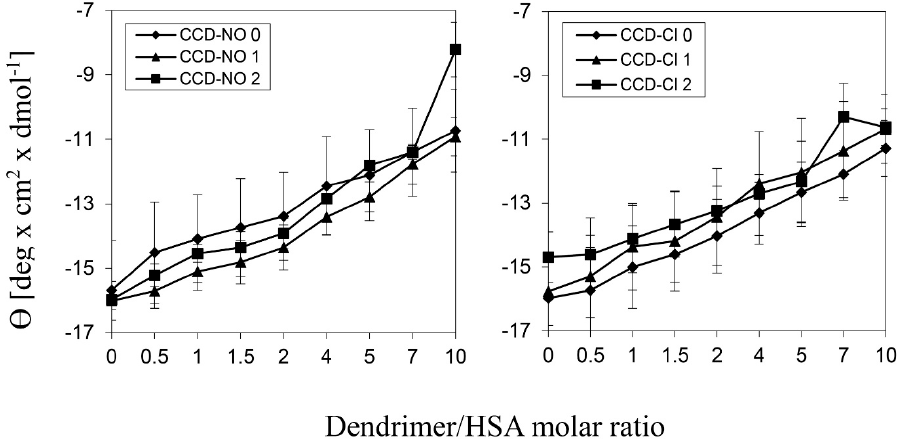
Figure 4. Changes in mean residue ellipticity of HSA, at λ = 210 nm in the presence of metallodendrimers. Results are mean ± standard deviation (SD), n = 3. HSA concentration 0.25 Results are mean ± standard deviation (SD), n = 3. HSA concentration 0.25 µ mol / L, wavelength µmol/L, wavelength 195–260 nm, scan speed 50 nm/min, bandwidth 1.0 nm, Na-phosphate buffer 10 195–260 nm, scan speed 50 nm / min, bandwidth 1.0 nm, Na-phosphate bu ff er 10 mmol / L, pH mmol/L, pH 7.4.